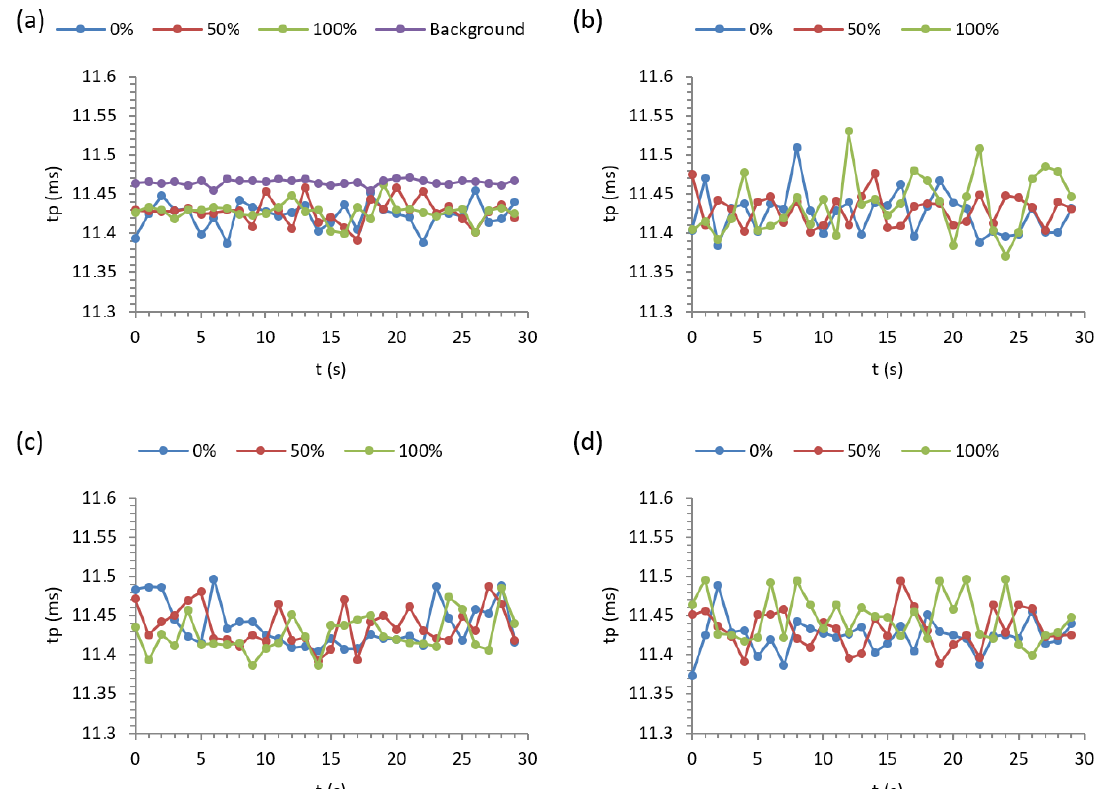
Figure 4. Graphs of the ultrasonic wave propagation time (AR30), with the direction of propagation